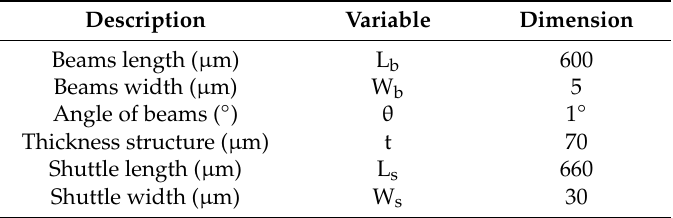
Table 3. Geometrical parameters of the chevron microactuator.